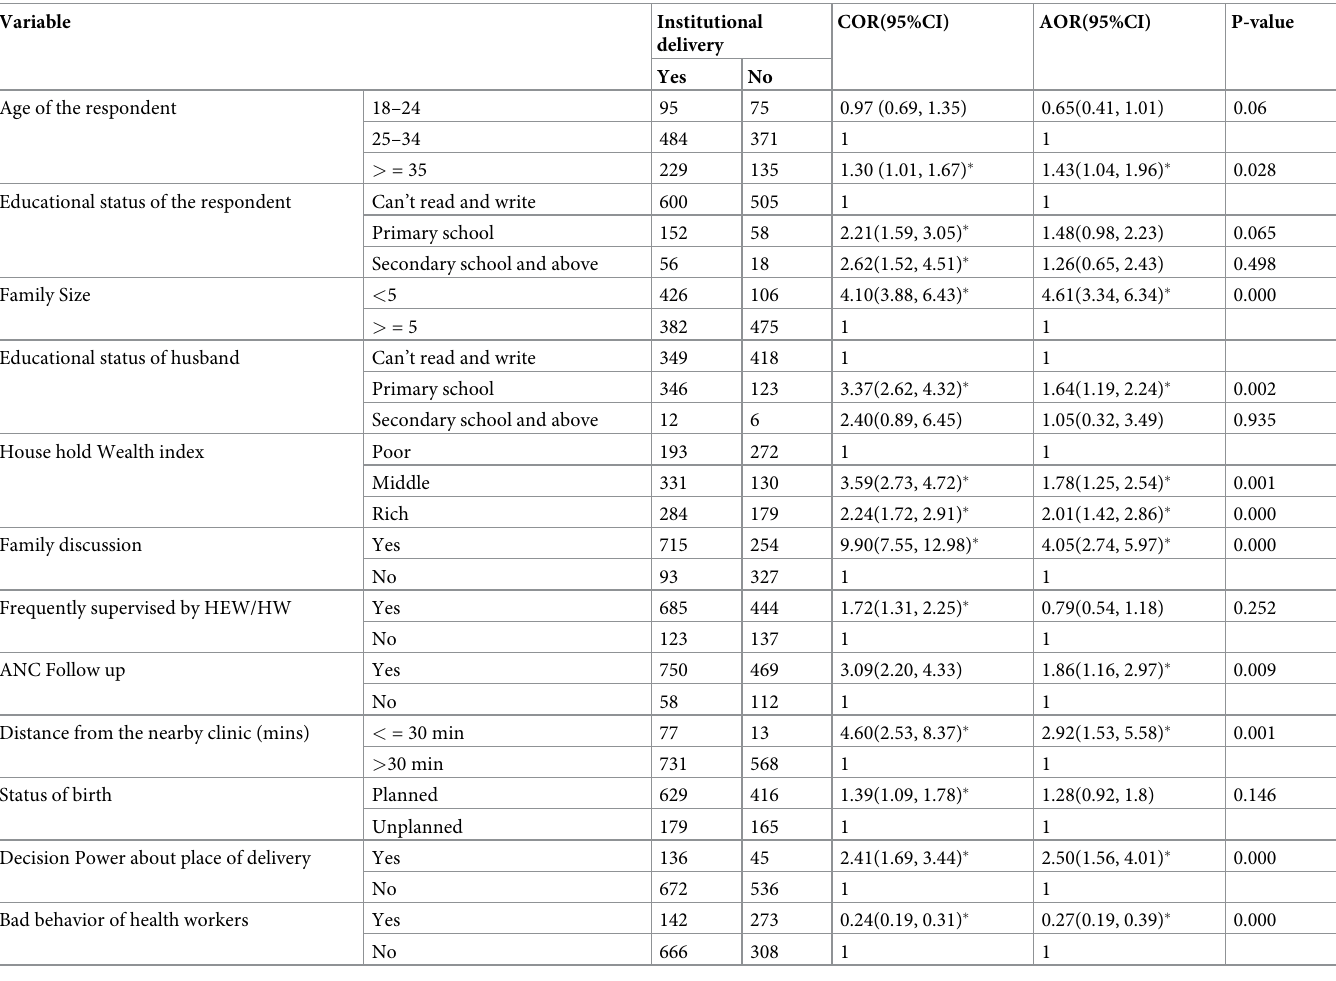
Table 4. Bivariable and multivariable analysis of factors associated with institutional delivery in Central Gondar zone, Amhara regional state, Northwest Ethiopia